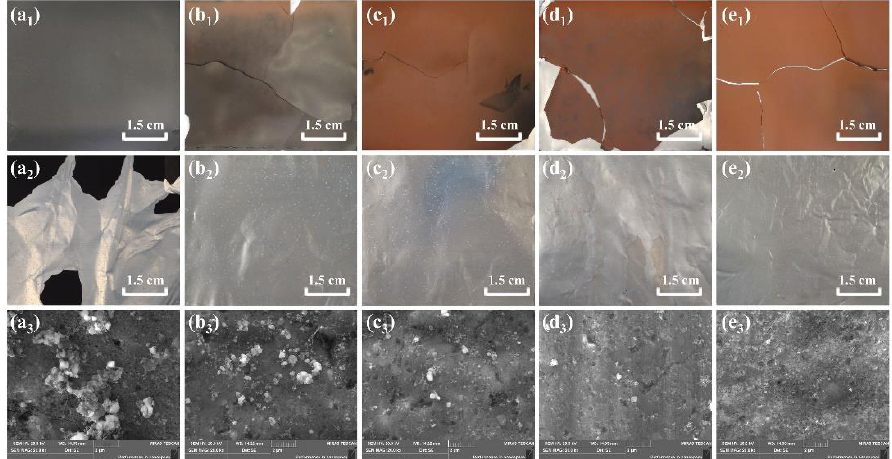
Figure 6. E ff ect of oxygen concentration on spent LiFePO 4 cathode plates: ( a 1 – e 1 ) Images of cathode Figure 6. Effect of oxygen concentration on spent LiFePO 4 cathode plates: ( a 1 –f 1 ) Images of cathode plates at 0–50 vol.% oxygen concentration; ( a 2 – e 2 ) Images of Al foils at 0–50 vol.% oxygen concentration; plates at 0–50 vol.% oxygen concentration; ( a 2 –f 2 ) Images of Al foils at 0–50 vol.% oxygen ( a 3 – e 3 ) SEM images of Al foils at 0–50 vol.% oxygen concentration; ( a 3 –f 3 ) SEM images of Al foils at 0–50 vol.% oxygen concentration.